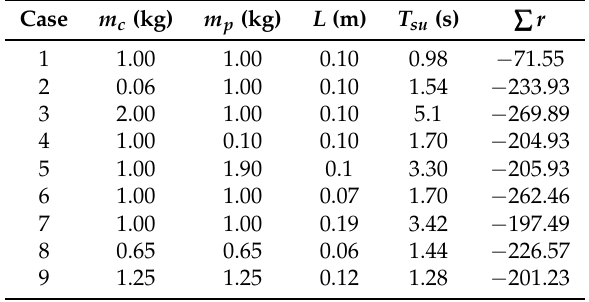
Table 2. Cases of the sensitivity analysis of agent A without the presence of dry friction ( µ = 0 ) .